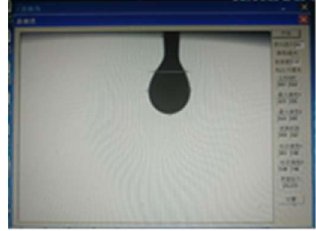
Figure 6. Contact angle of water on the surface of three materials Table 4. Experimental data of contact